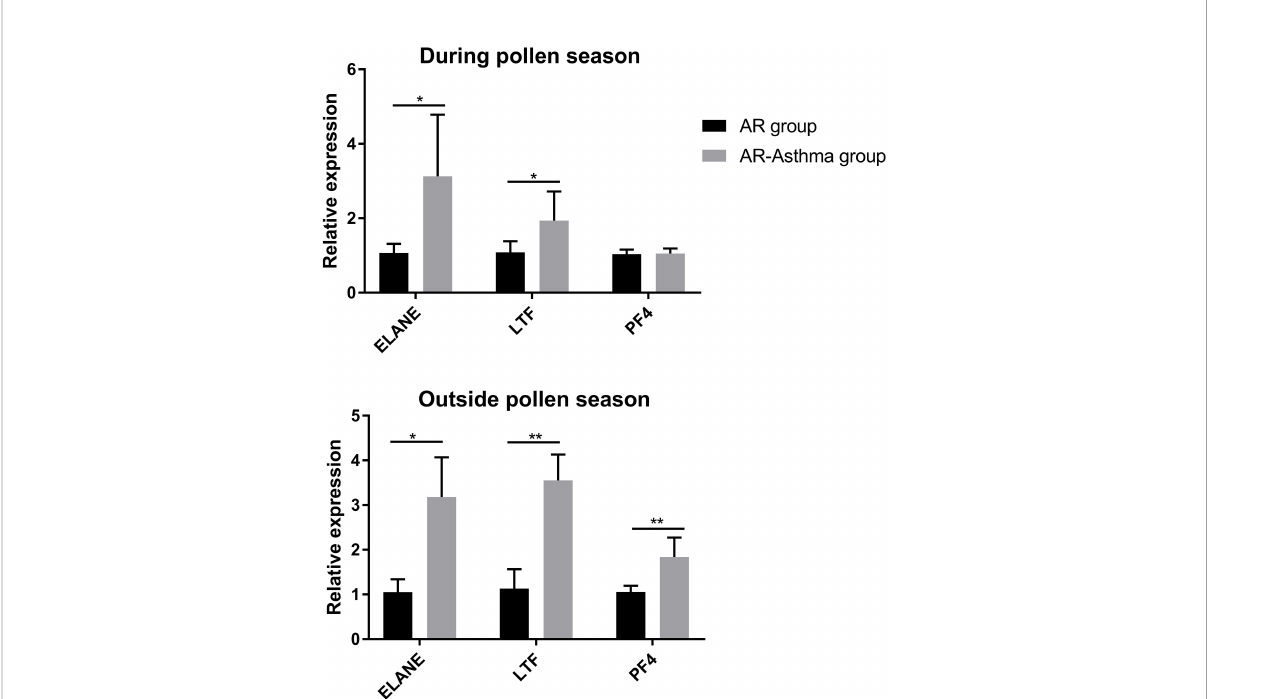
FIGURE 5 Quantitative PCR validation of three key DEGs between the AR-asthma group and AR group during the pollen season and outside the pollen season. AR, allergic rhinitis; DEGs, differentially expressed genes; PCR, polymerase chain reaction; * P < 0.05; ** P <